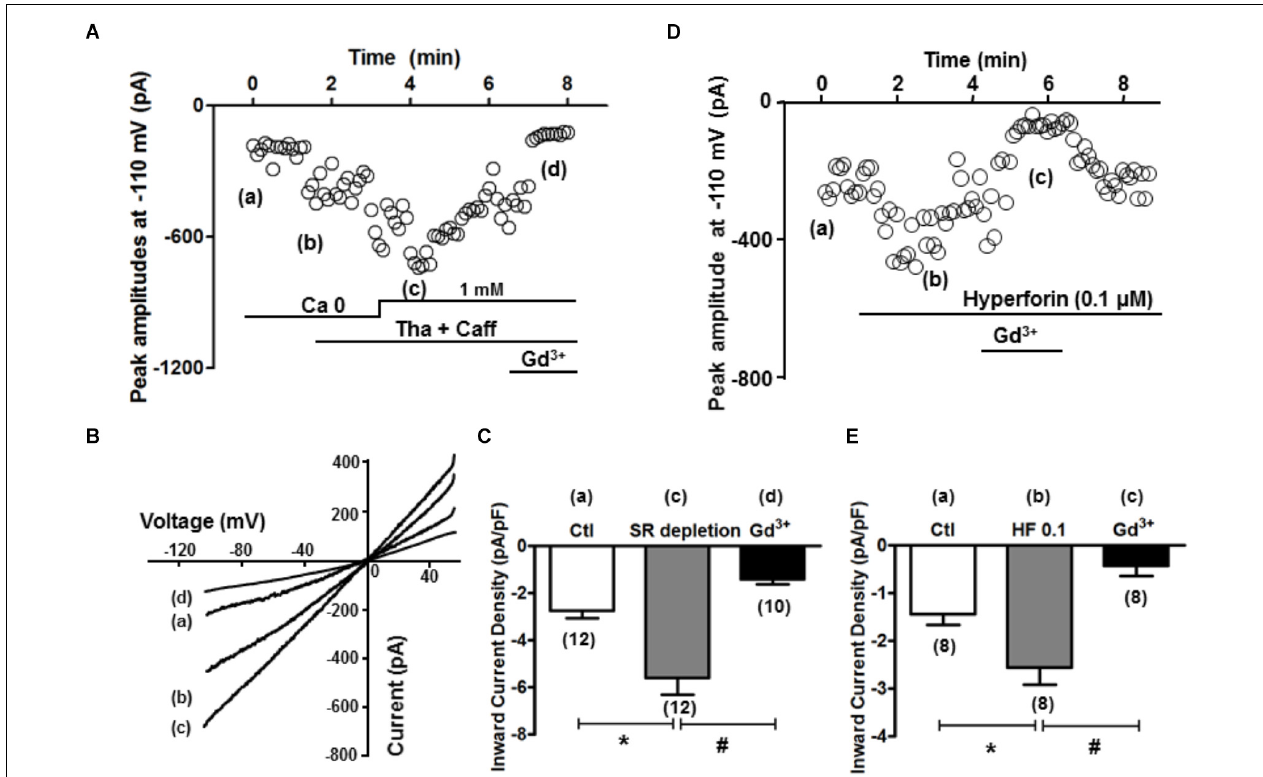
FIGURE 5 | SR depletion and the presence of hyperforin induced significant inward current. (A) A representative plot of currents measured at –110 mV over time. The same treatment protocol to deplete SR Ca 2 + (Tha + Caff) was used. (B) I–V curves at time points a–d (control, calcium free, after SR depletion, and in the presence of Gd 3 + , respectively) indicated in (A) . (C) Summary of the inward current densities at –110 mV measured under control and after SR depletion ( ∗ p < 0.05, Student’s t -Test). (D) A representative plot of currents measured at –110 mV over time, and the presence of hyperforin induced significant inward current entry. (E) Summary of the inward current densities at –110 mV measured under control and after SR depletion. Hyperforin (0.1 µ M) induced a significant increase of inward current (from –1.4 ± 0.2 pA/pF to –2.6 ± 0.4 pA/pF, n = 8, ∗ p < 0.05), which was then inhibited by the SOCE blocker Gd 3 + (1 mM) (–0.4 ± 0.2 pA/pF, n = 8, ∗ p < 0.05, Student’s t